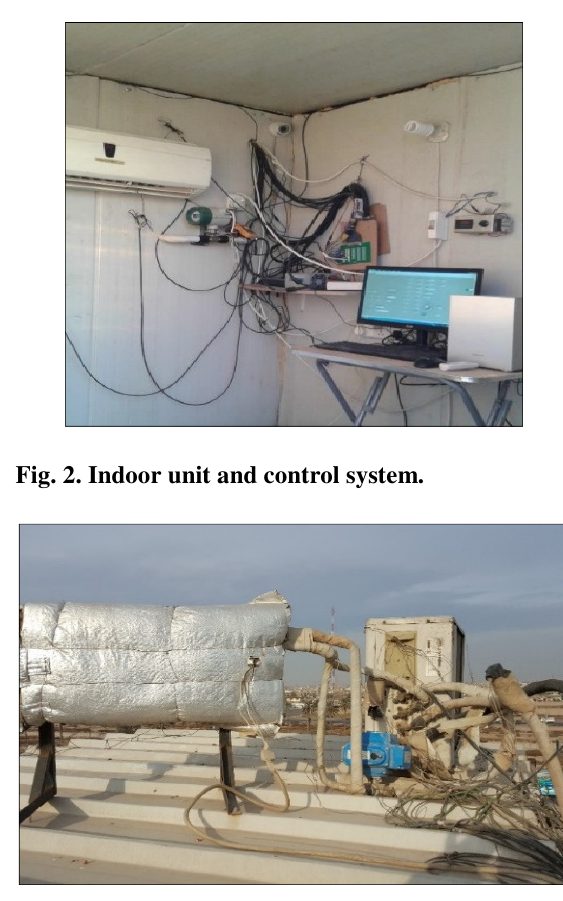
A twisted strip is inserted inside the pipe to increase the heat transfer rate between the refrigerant and pipe wall. The box is insulated from outside with glass wool and aluminum foil. A variac transformer is used to control the output power of the electrical heater manually. Fig. 4 represents the details of the electrical heater.